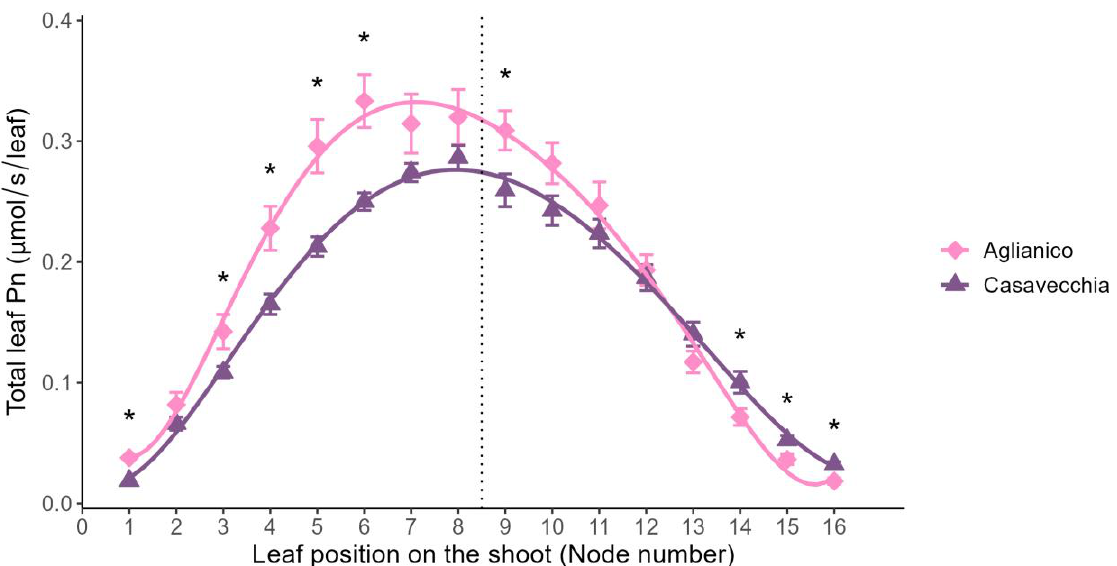
Figure 2. Estimated total net photosynthetic rate of leaves located at different shoot nodes of ‘Aglianico’ and ‘Casavecchia’ grapevines. Error bars are the standard errors of the mean. Asterisks indicate significant differences between cultivars for each leaf position (one-way ANOVA, p ≤ 0.05). A dotted vertical line separates the basal leaves (nodes from 1 to 8) removed in vines exposed to basal defoliation from the apical leaves (nodes from 9 to 16) removed in vines exposed to apical defoliation or shoot trimming.